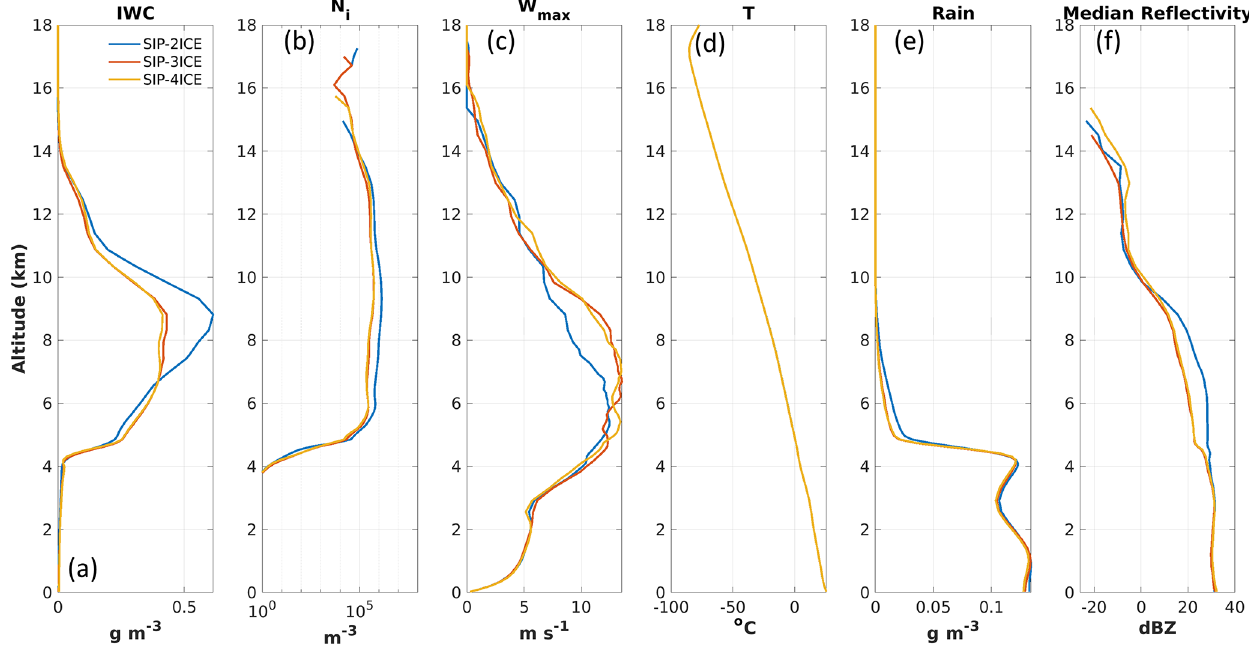
Figure 5. Same as Fig. 4 but for the SIP simulation with two, three, and four ice